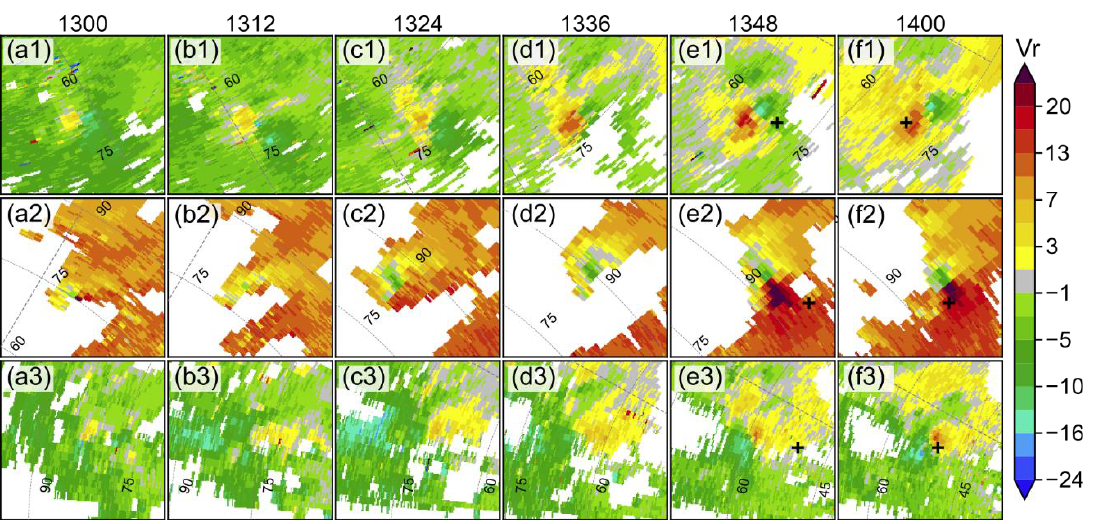
Figure 5. Radial velocity fields of the meso-  supercell from 1300 to 1400 LTC. Each row ( 1 – 3 ) shows radial velocity fields from one radar at the 0.5° elevation angle, and each column ( a – f ) shows the supercell at a different time. The black cross in ( e – f ) represents the tornado location.